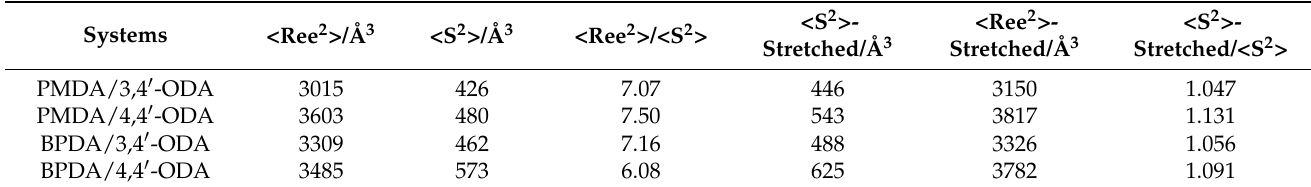
Table 1. <Ree 2 > and <S 2 > before and after